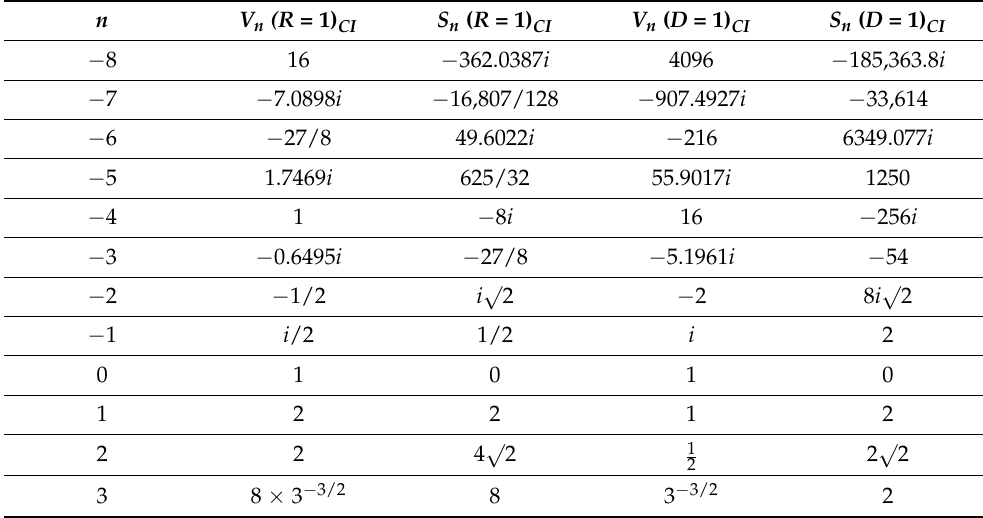
Figure 7. Graphs of volumes (( a , b ), pink) and surfaces (( c , d ), blue) of unit radius n -balls, along with volumes and surface areas of n -cubes circumscribed about (yellow) and inscribed in (green, black) these n -balls. Table 2. Volumes and surfaces of n -cubes inscribed in n -balls of unit radius and diameter for −8 ≤ n ≤ 3 (rational fraction approximation using Matlab rats function).